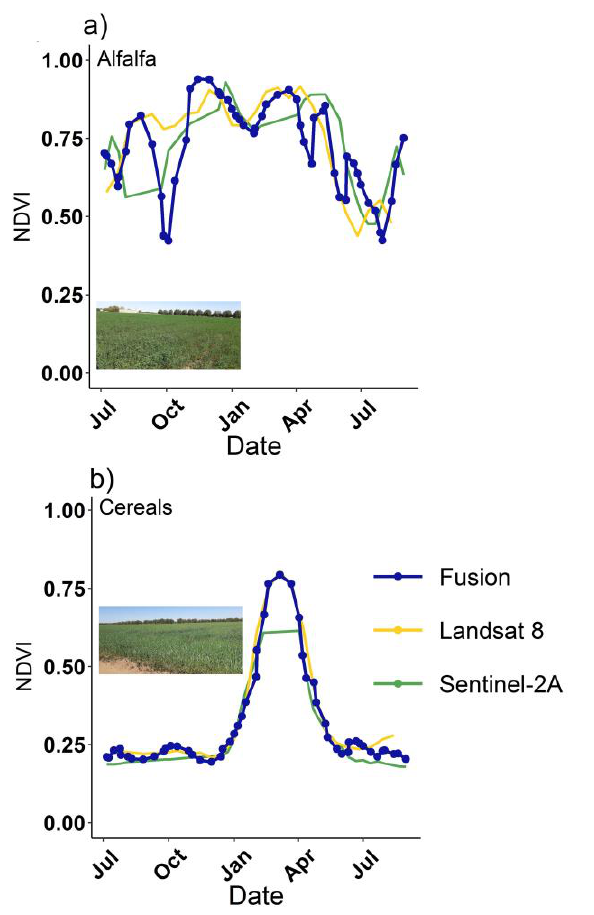
Figure 5. Comparison of NDVI temporal profiles obtained from Landsat, Sentinel-2, and their combined use by SRCNN spatiotemporal fusion method over an a) alfalfa and b) wheat